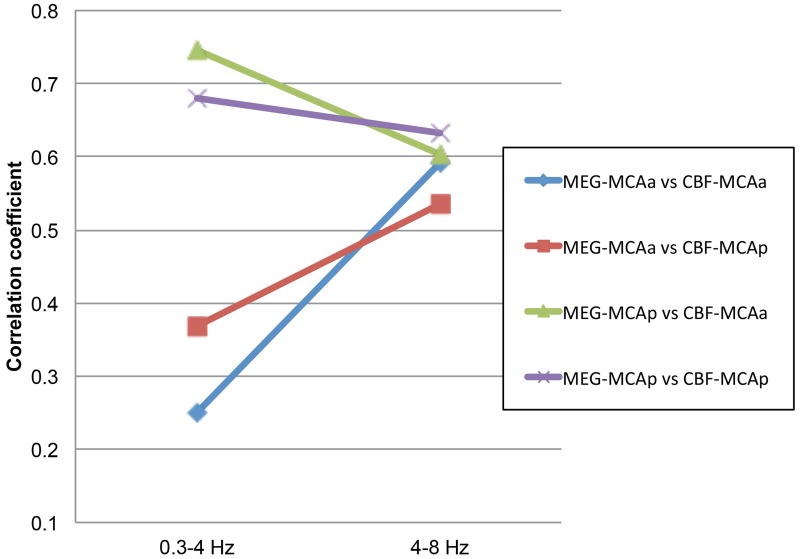
Correlation coefficient between the CBF and MEG in the ROIs of the MCAa and MCAp.Line plot graph showing absolute values of the correlation coefficient between CBF-LI and MEG-LI in the ROIs of the MCAa and MCAp. We observed a high correlation between 0.3- to 4-Hz wave laterality in the MCAp and CBF-LI in the MCAa (r = 0.68, p < 0.01) and MCAp (r = 0.74, p < 0.01), whereas no significant correlation was recognized between 0.3- to 4-Hz wave laterality in the MCAa and CBF-LI in the MCAa (r = 0.25, p = 0.13) or MCAp (r = 0.37, p = 0.02). We found a moderate correlation between 4- to 8-Hz wave laterality and CBF-LI in the ROIs of the MCAa and MCAp.